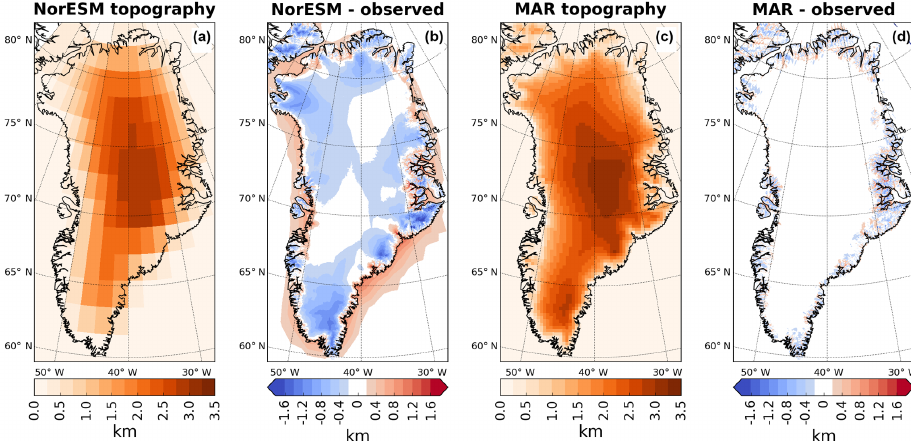
Figure 4. Greenland model topographies and differences to observed Greenland topography from Schaffer et al. (2016). (a) NorESM Green- land topography, on the original resolution of 1 . 9 × 2 . 5 ◦ (latitude/longitude), (b) NorESM minus observed, (c) MAR Greenland topography (on original resolution of 25 × 25km), and (d) MAR minus